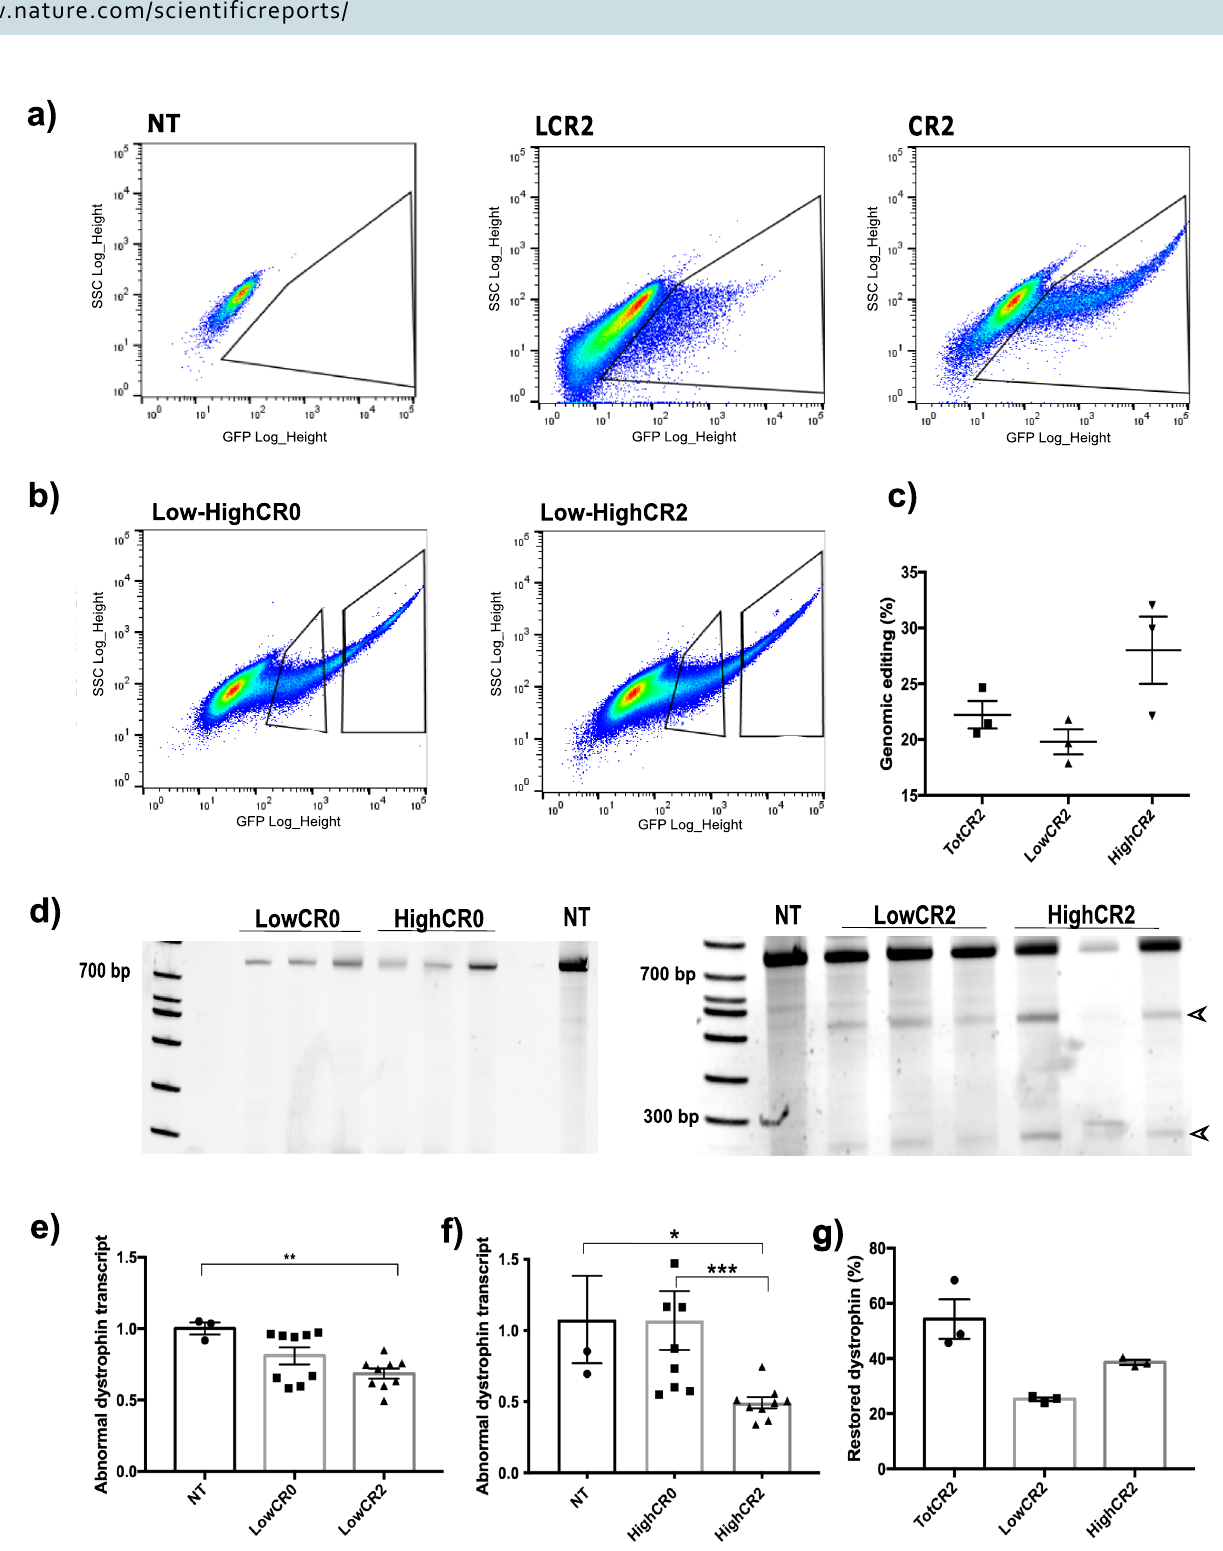
Figure 4. The intensity of transient Cas9 expression affects dystrophin restoration. ( a ) Comparison of CRISPR/Cas9 expression intensity by FACS analysis of transduced (LCR2) and electroporated DUPmyo (CR2). ( b ) FACS analysis of electroporated DUPmyo-i cells gated according to their GFP expression intensity (high/low). ( c ) Percentages of genomic targeting achieved in cell populations expressing different CRISPR/Cas9 levels (n = 3). ( d ) T7E1 assay of cells expressing high and low level of CR0 and CR2 nucleases (n = 3). Arrows indicate expected cleaved bands in cells expressing CR2. ( e ) Reduction of mutated dystrophin transcript observed in cells expressing both low (Kruskal–Wallis test: p = 0.028, Mann–Whitney test: p = 0.0091) and high ( f ) levels of CR2 (Kruskal– Wallis test: p = 0.0005, Mann–Whitney tests: p = 0.0182 and p = 0.0008 (n = 3 technical replicates/sample). ( g ) Comparison of average percentages of restored dystrophin observed in cells expressing TotCR, LowCR2 and HighCR2 (n = 3). NT = untreated cells. LowCR0/ LowCR2 = cells expressing a low level of CR0/CR2. HighCR0/CR2 = cells expressing high levels of CR0/CR2. TotCR2 = total pool of cells expressing CR2. WT = protein derived from the immortalized murine H2K 2B4 cells, expressing wild-type dystrophin (positive